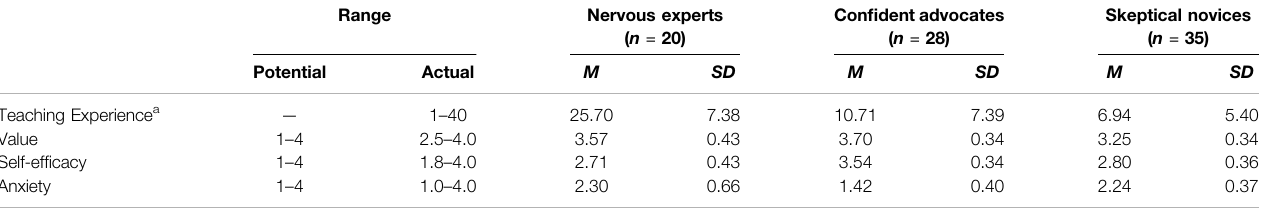
TABLE 3 | Teaching experience and pretest scores for the measures value, self-ef fi cacy and anxiety, for the three teacher orientations identi fi ed via clustering.